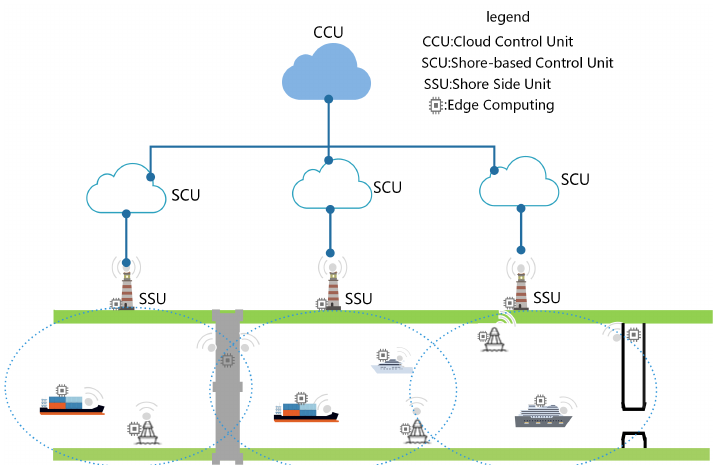
Figure 14. The organizational structure of an autonomous waterborne transportation